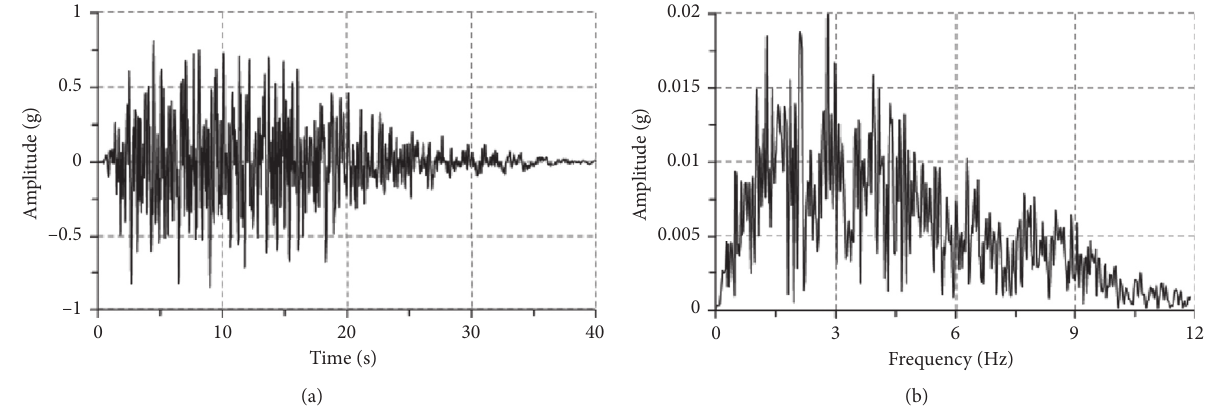
Figure 5: The input seismic wave: (a) time history; (b) Fourier